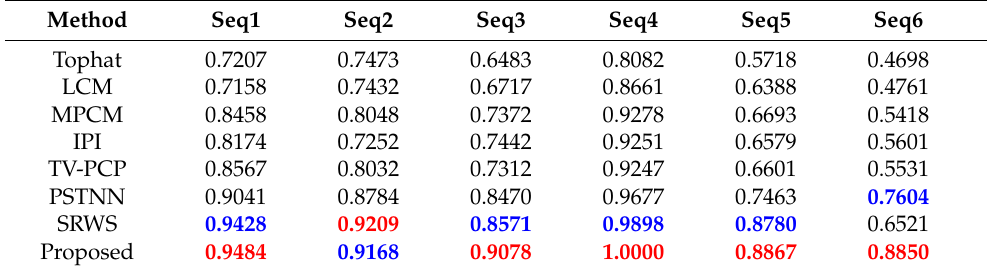
Table 3. AUC values of eight methods (bold red number: maximum value; bold blue number: second-highest value).